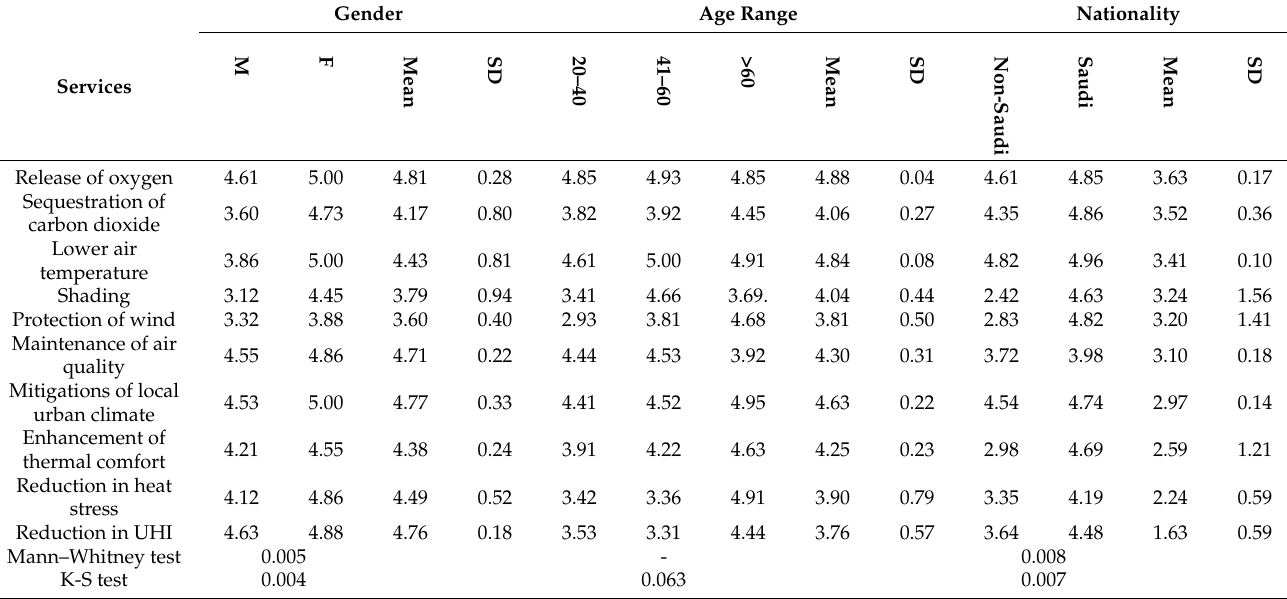
Table 4. Perceived importance of GS based on age, gender, and